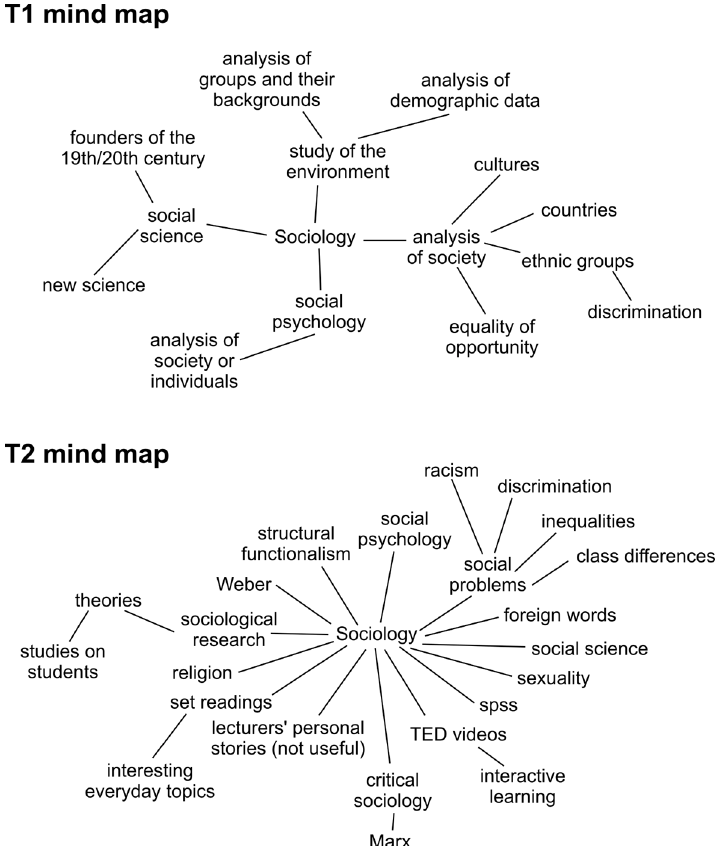
Figure 2. Example of a “surface learning” outcome. Even though T2 contains much more information, the structure barely goes beyond one level, many aspects are half-baked.